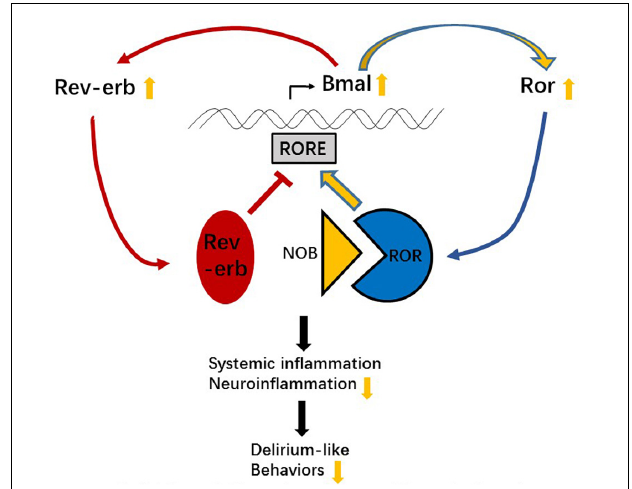
FIGURE 9 | Schematic illustration of the possible mechanism of nobiletin (NOB) attenuating inflammation and postoperative cognitive dysfunction (POCD)-like